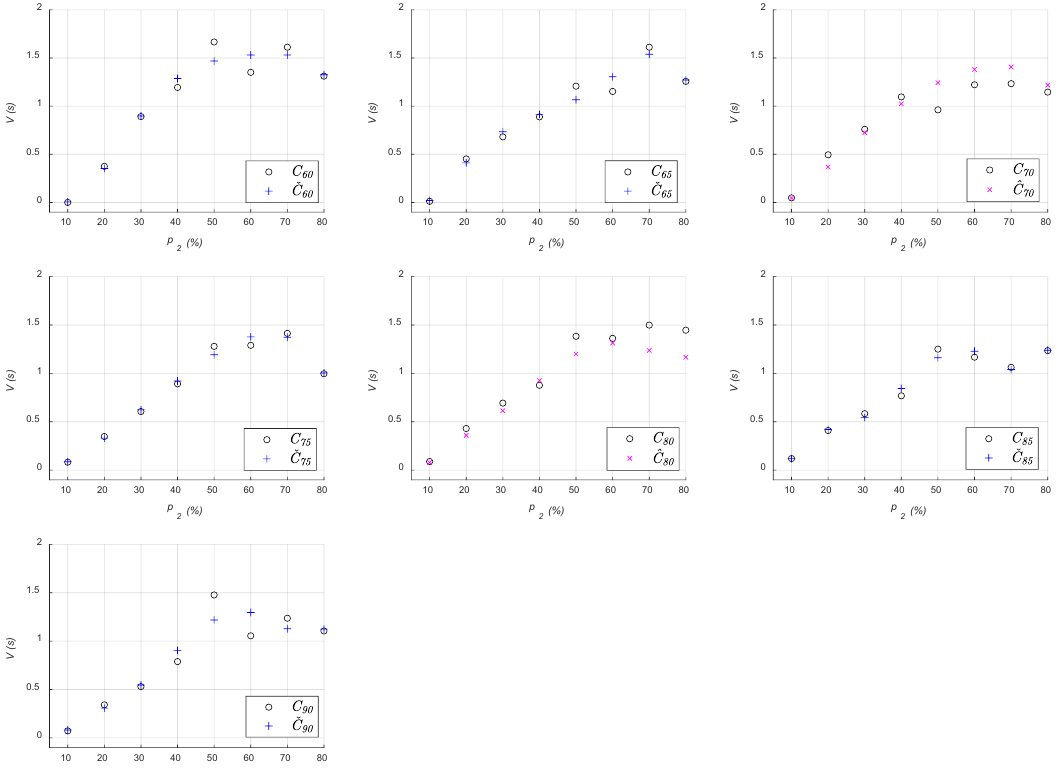
vs. V (procedure 5). Figure 5. p 2 vs. V (procedure Figure 5. 𝑠𝑠 2